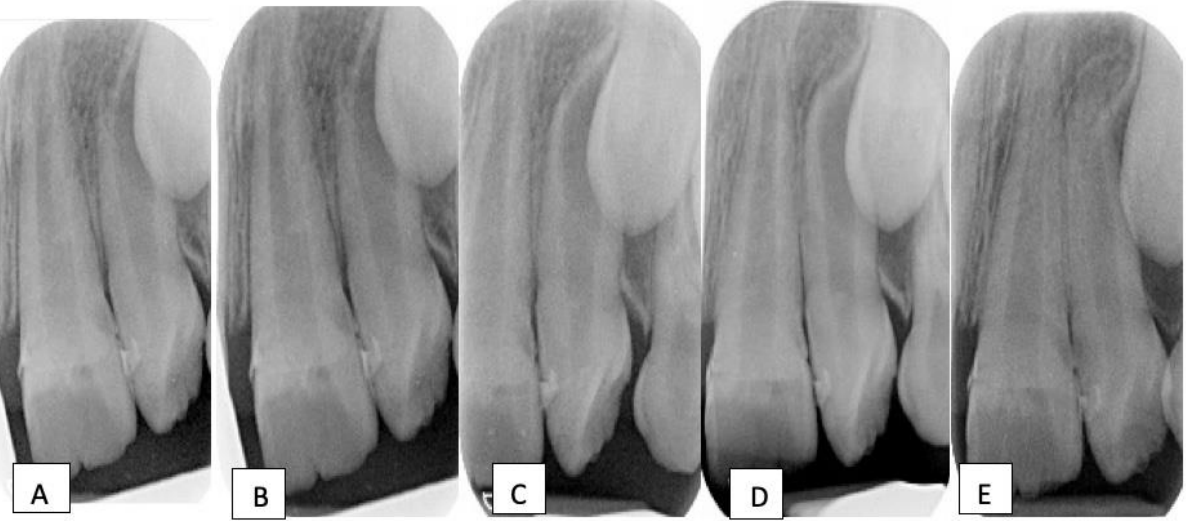
Figure 4. Radiographic evaluation of 11 & 21; ( A ) 2 weeks after the surgery (immediate post-operative review), ( B ) at 3-month, ( C ) at 6-month, ( D ) at 12-month, ( E ) at 24-month recall visits. Notice the continued root development and the apical closure in the hypoplastic teeth.